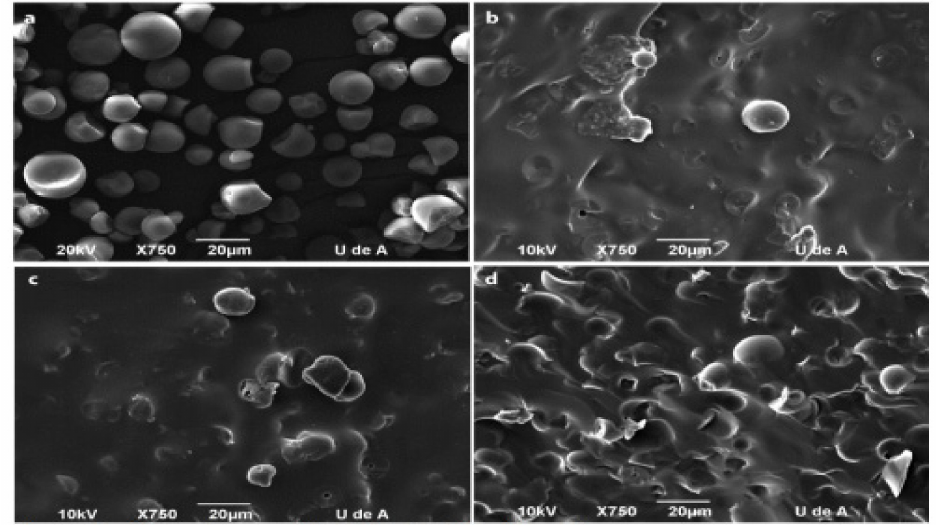
Figure 2. SEM micrographs of the starch and thermoplastic starch (TPS): starch ( a ), TPS30 ( b ) TPS40 ( c ) and TPS50 ( d ). Reprinted with permission from ref. [25]. Copyright 2018 Universidad Nacional de